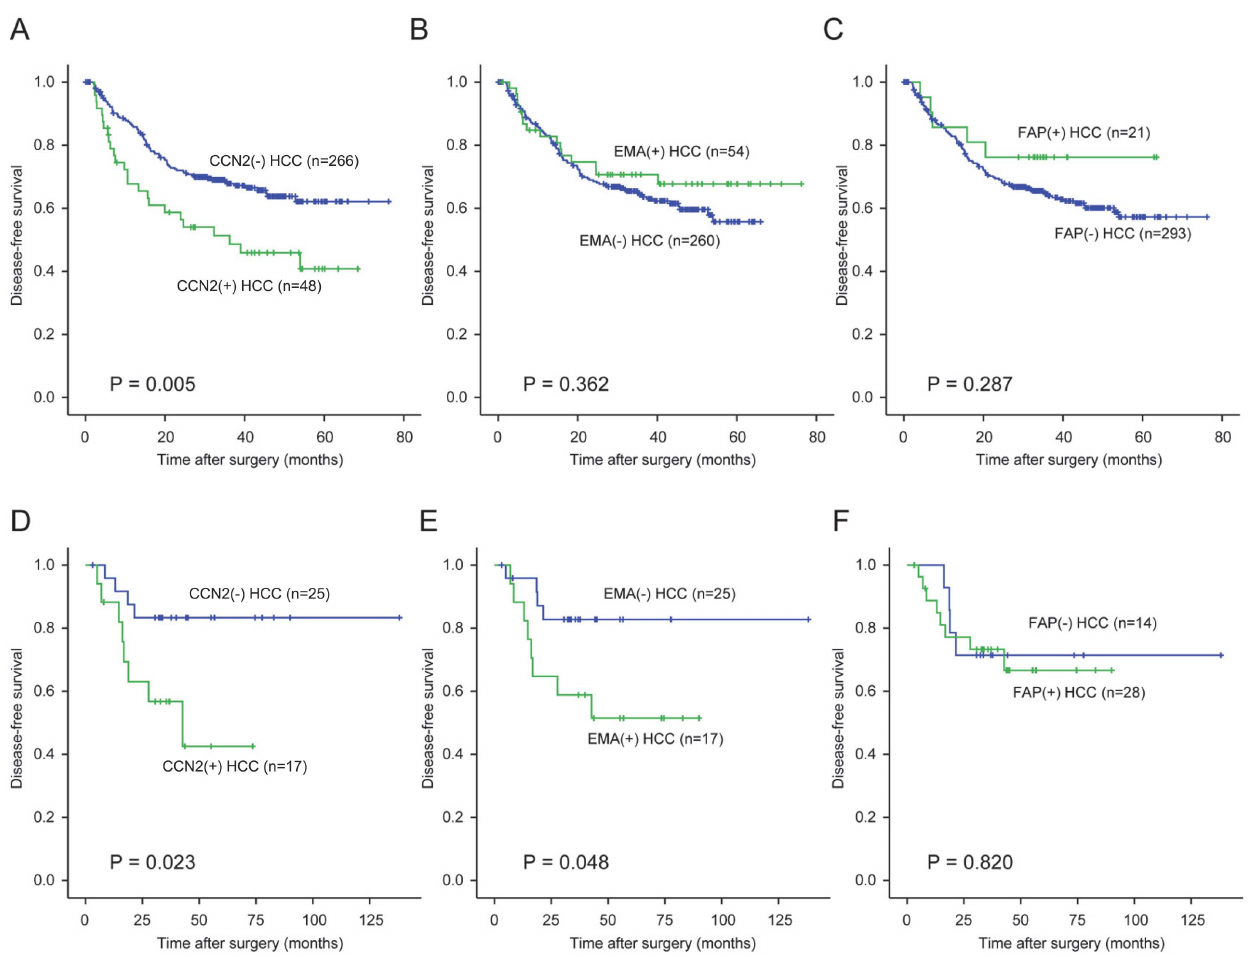
Figure 4. Disease-free survival (DFS) analysis of hepatocellular carcinoma (HCC) patients according to the expressions of connective tissue growth factor (CCN2), epithelial membrane antigen (EMA), and fibroblast activation protein (FAP). A–C) DFS analysis of HCC patients in cohort 1. HCC patients with positive expression of CCN2 (A) exhibit a significantly worse DFS curve compared to those without ( P =0.005). There is no significant difference in DFS rate according expression of EMA (B) or FAP (C). D–F) DFS analysis of scirrhous HCC patients (cohort 2). CCN2 (D) and EMA (E) expression significantly influences DFS rates among scirrhous HCC patients ( P =0.023 and P =0.048, respectively), whereas there is no significant difference in DFS rate according to FAP expression